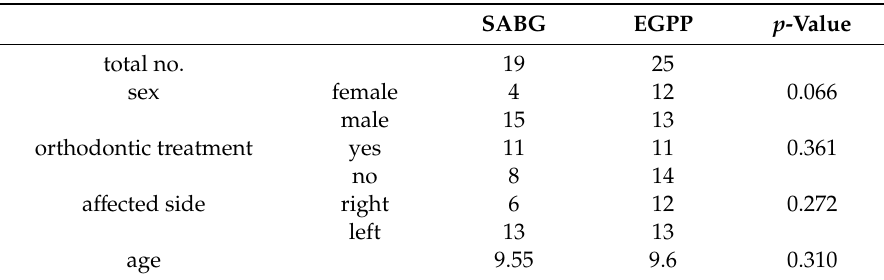
Table 1. Demographic data.